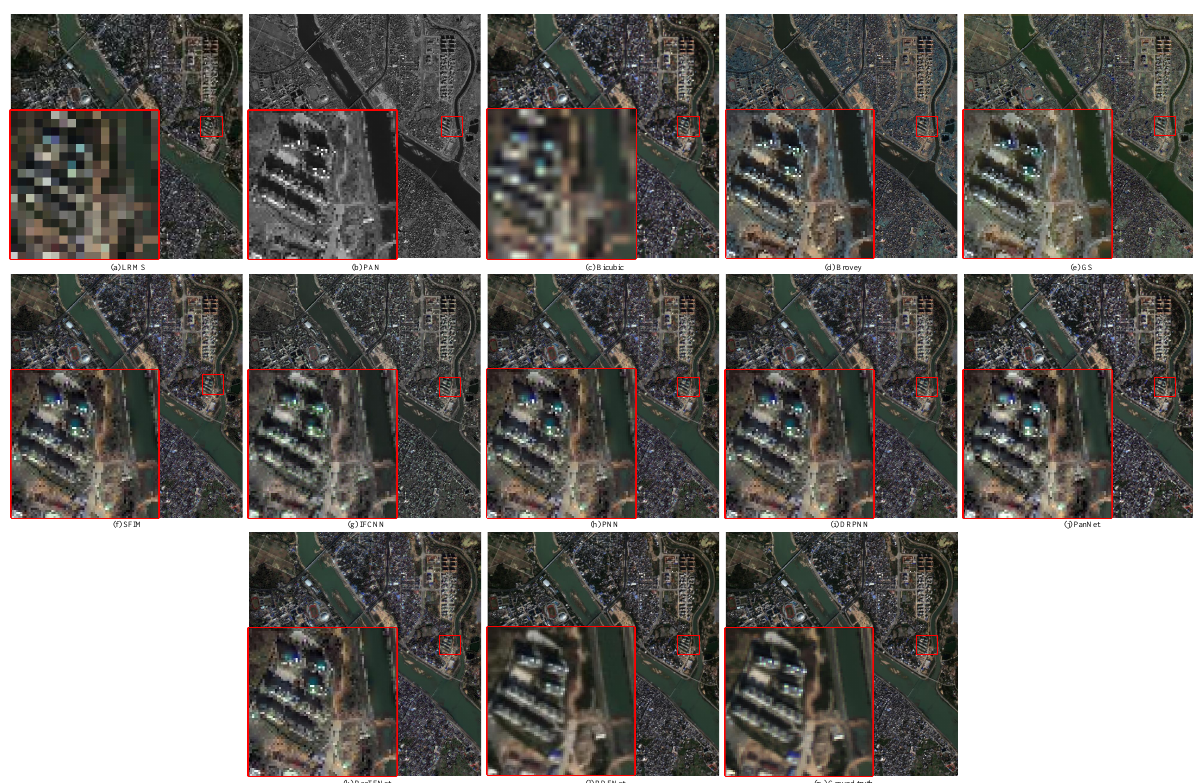
Figure 21. Subjective comparison between RDFNet and the current mainstream fusion methods for testing dataset fusion results of GF-2 with reduced resolution. ( a ) LRMS; ( b ) PAN; ( c ) Bicubic; ( d ) Brovey; ( e ) GS; ( f ) SFIM; ( g ) IFCNN; ( h ) PNN;